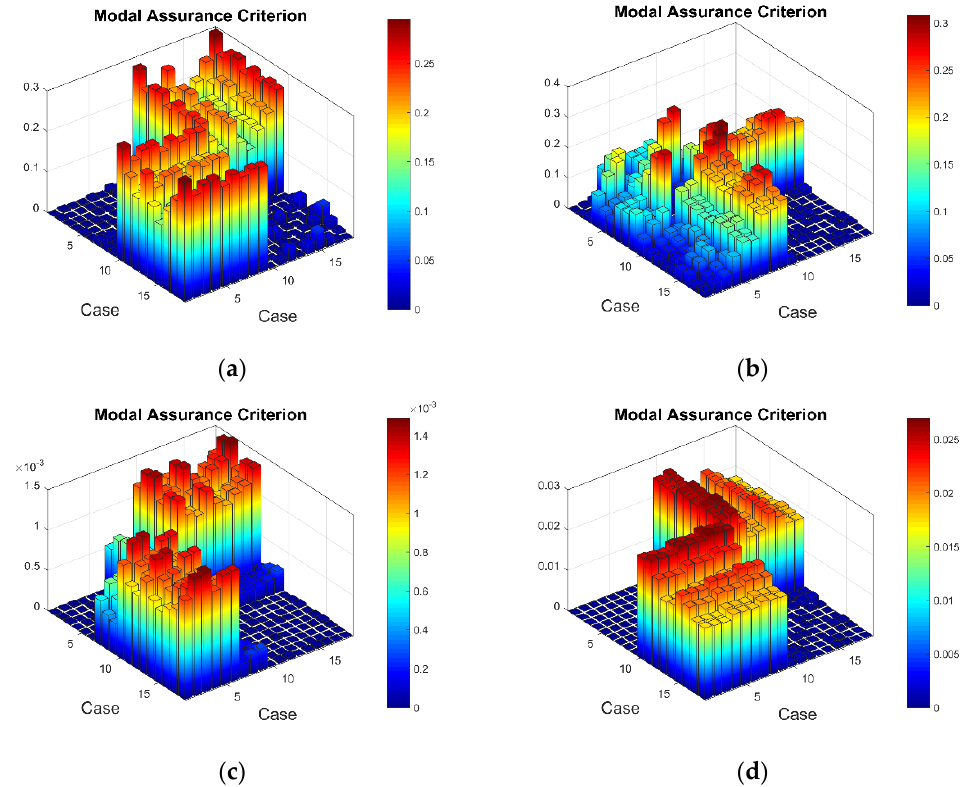
Figure 15. The MAC values for 18 sets of strain data: ( a ) healthy plate for the second resonant frequency, ( b ) damaged plate for the second resonant frequency, ( c ) healthy plate for the fifth resonant frequency, ( d ) damaged plate for the fifth resonant frequency.